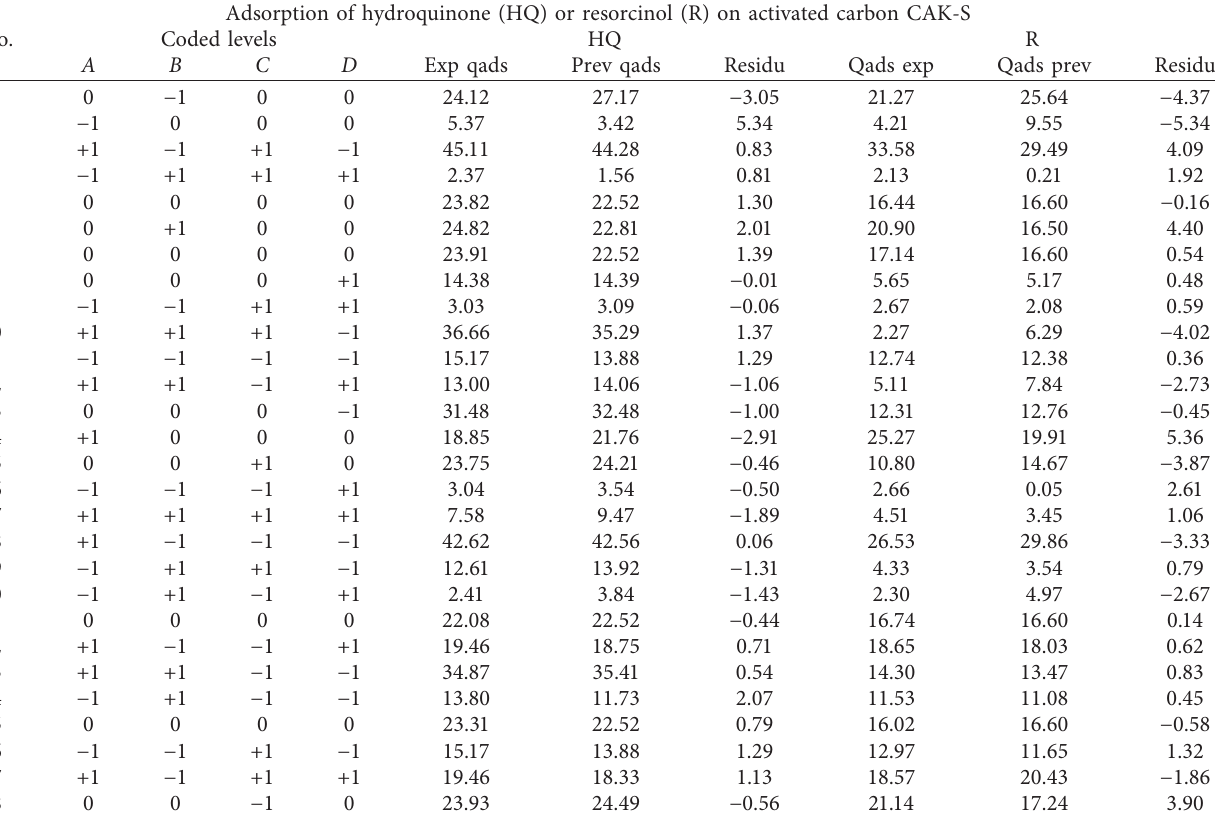
Table 5: Matrix of coded variables associated with experimental and predicted values of adsorption of hydroquinone or resorcinol on